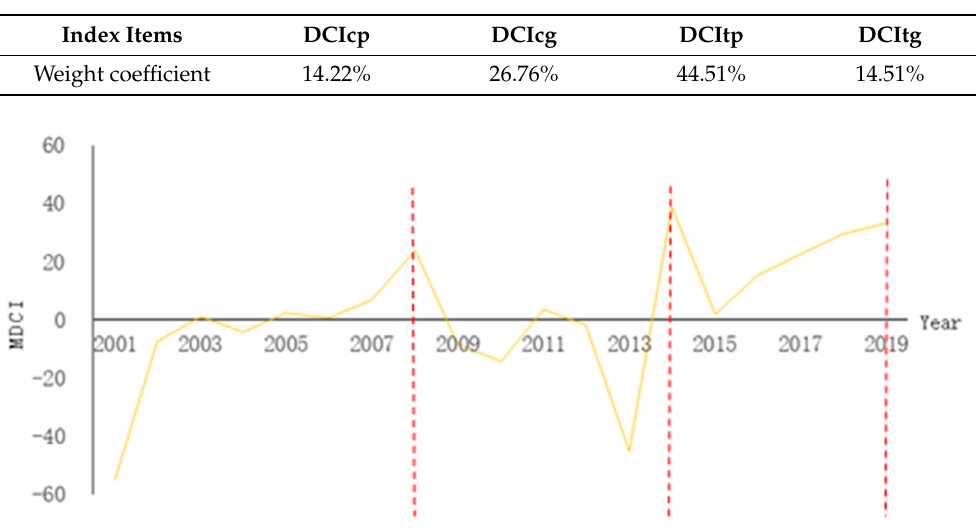
Table 1. Weight of cross DCI values.